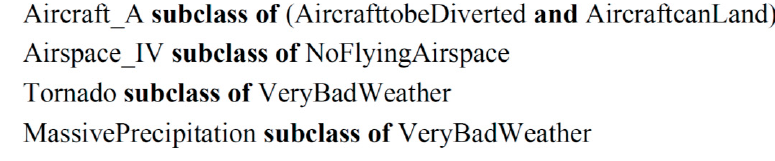
Figure 7. Examples of inferred classes.